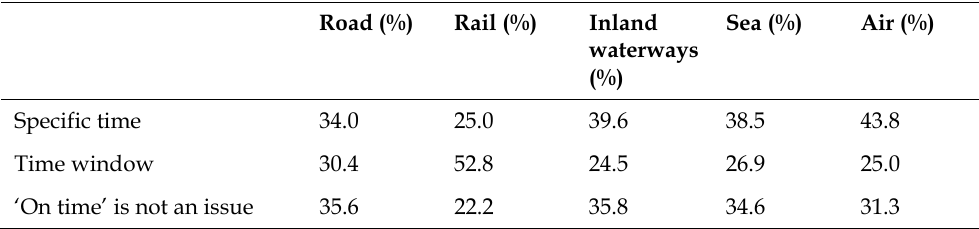
Table 3. Percentage of goods transports that need to deliver on